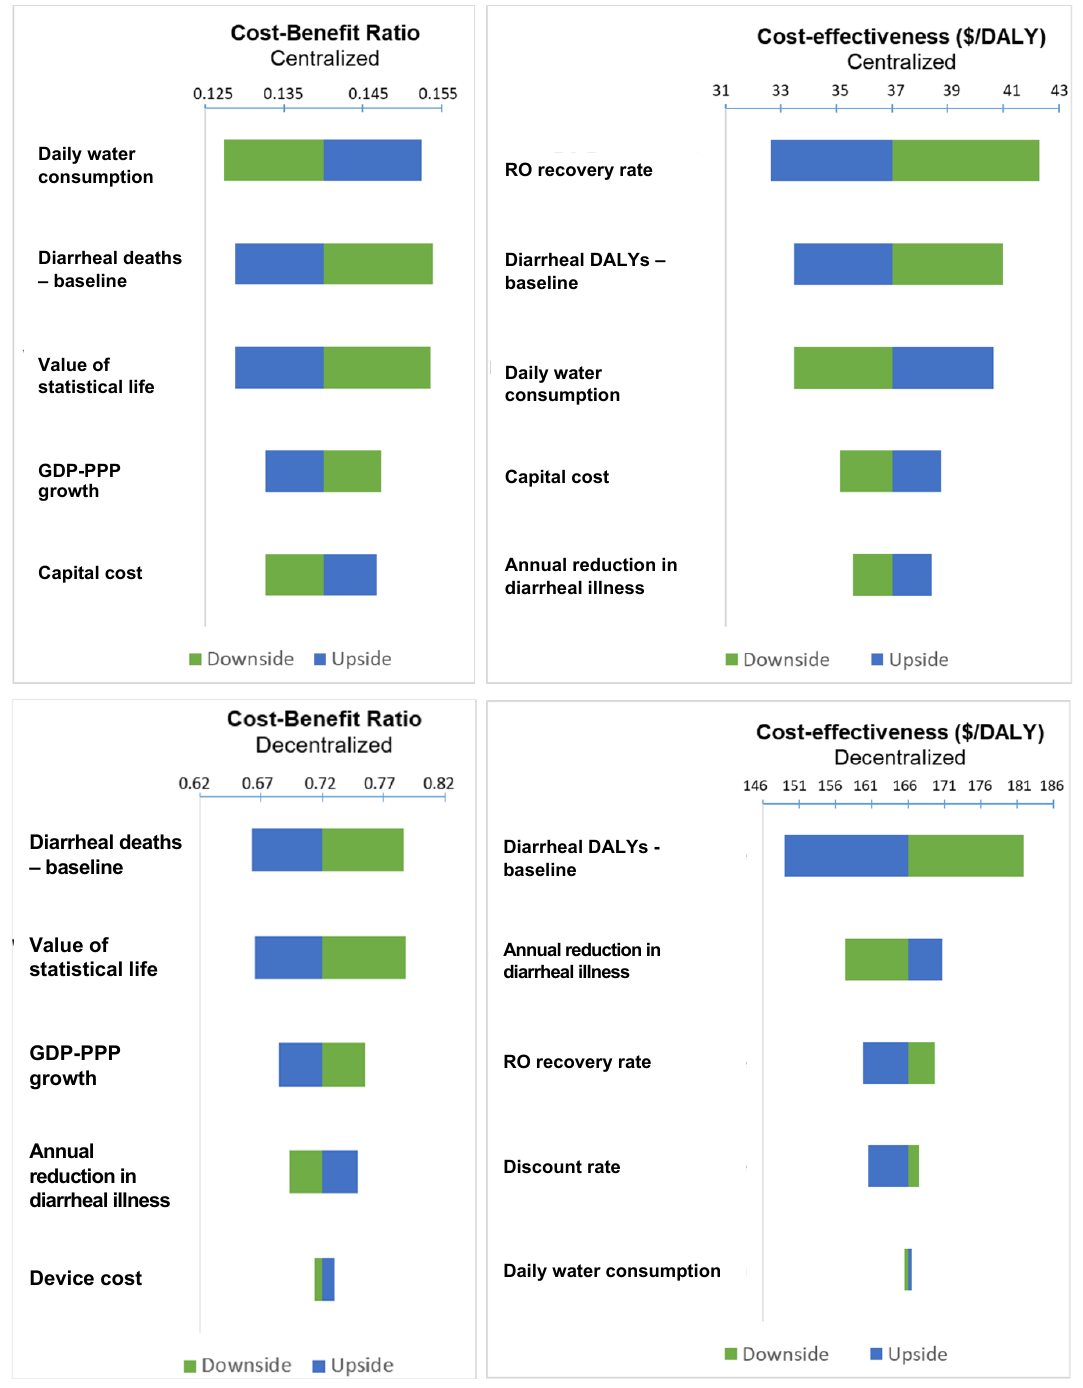
Figure 4. Tornado charts illustrating which model inputs are most influential for computing each kind of cost-effectiveness metric. The widths of the horizontal bars illustrate variability in output metric arising from ±10% perturbation in each input parameter value, while holding all other inputs constant. Green bars indicate the downside while blue bars indicate upside of each parameter.